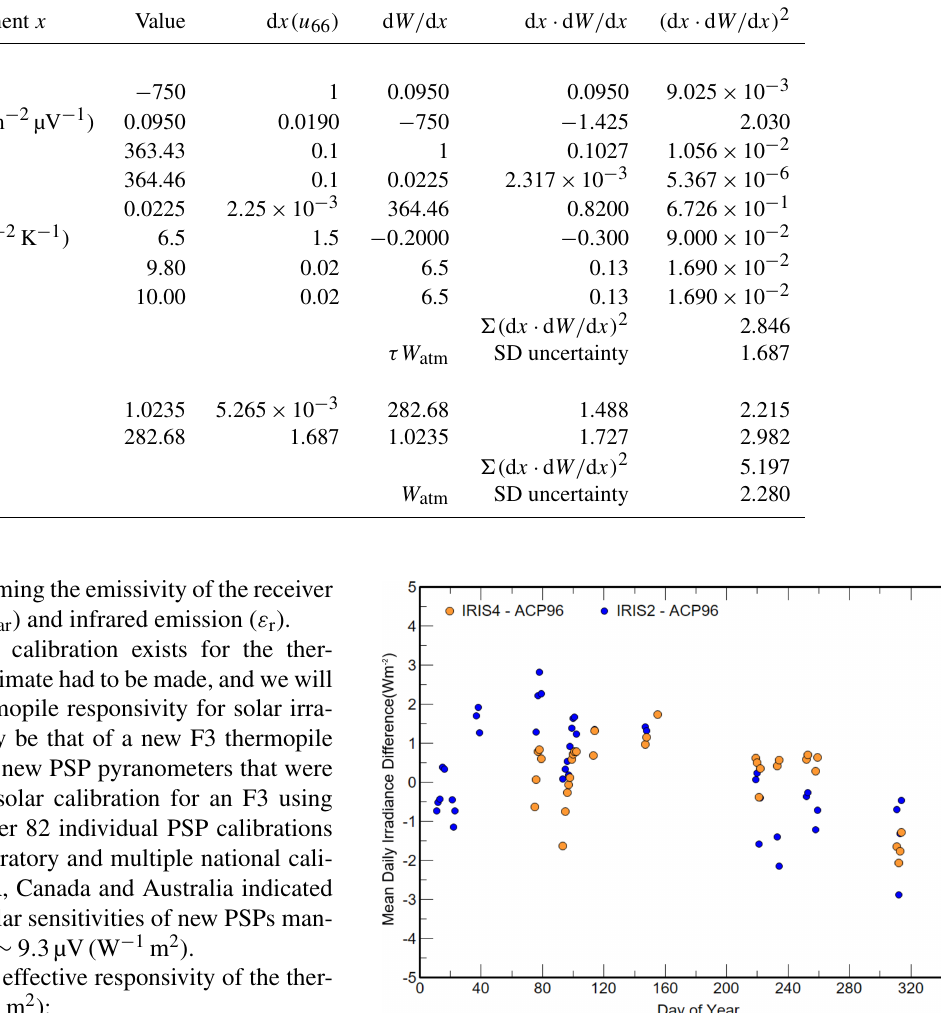
Figure 2. The daily mean differences and the statistics of ( W IRIS2 − W ACP96 ) and ( W IRIS4 − W ACP96 ) (Wm − 2 ) from January to Novem- ber 2020, using C = 10 . 5, γ = 8 . 4, τ = 0 . 977 and ε c = 0 .